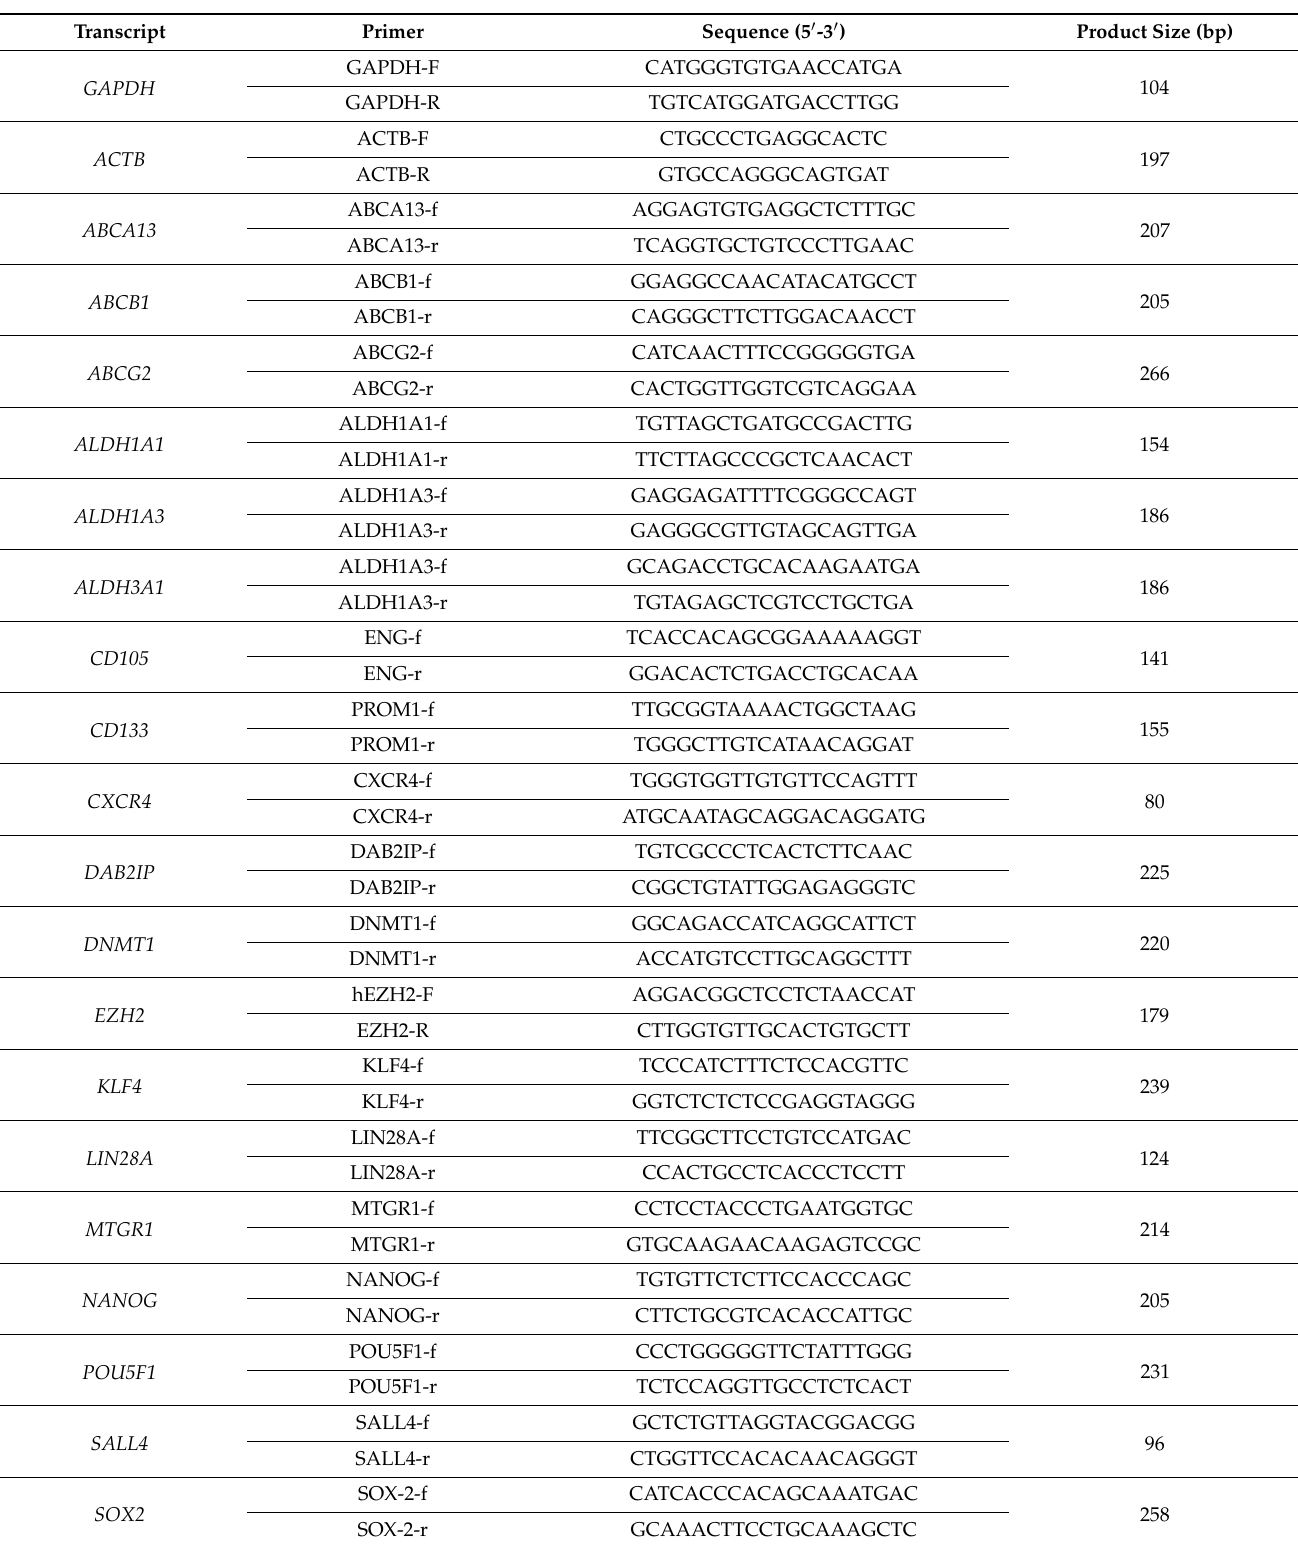
Table 1. The primers used for